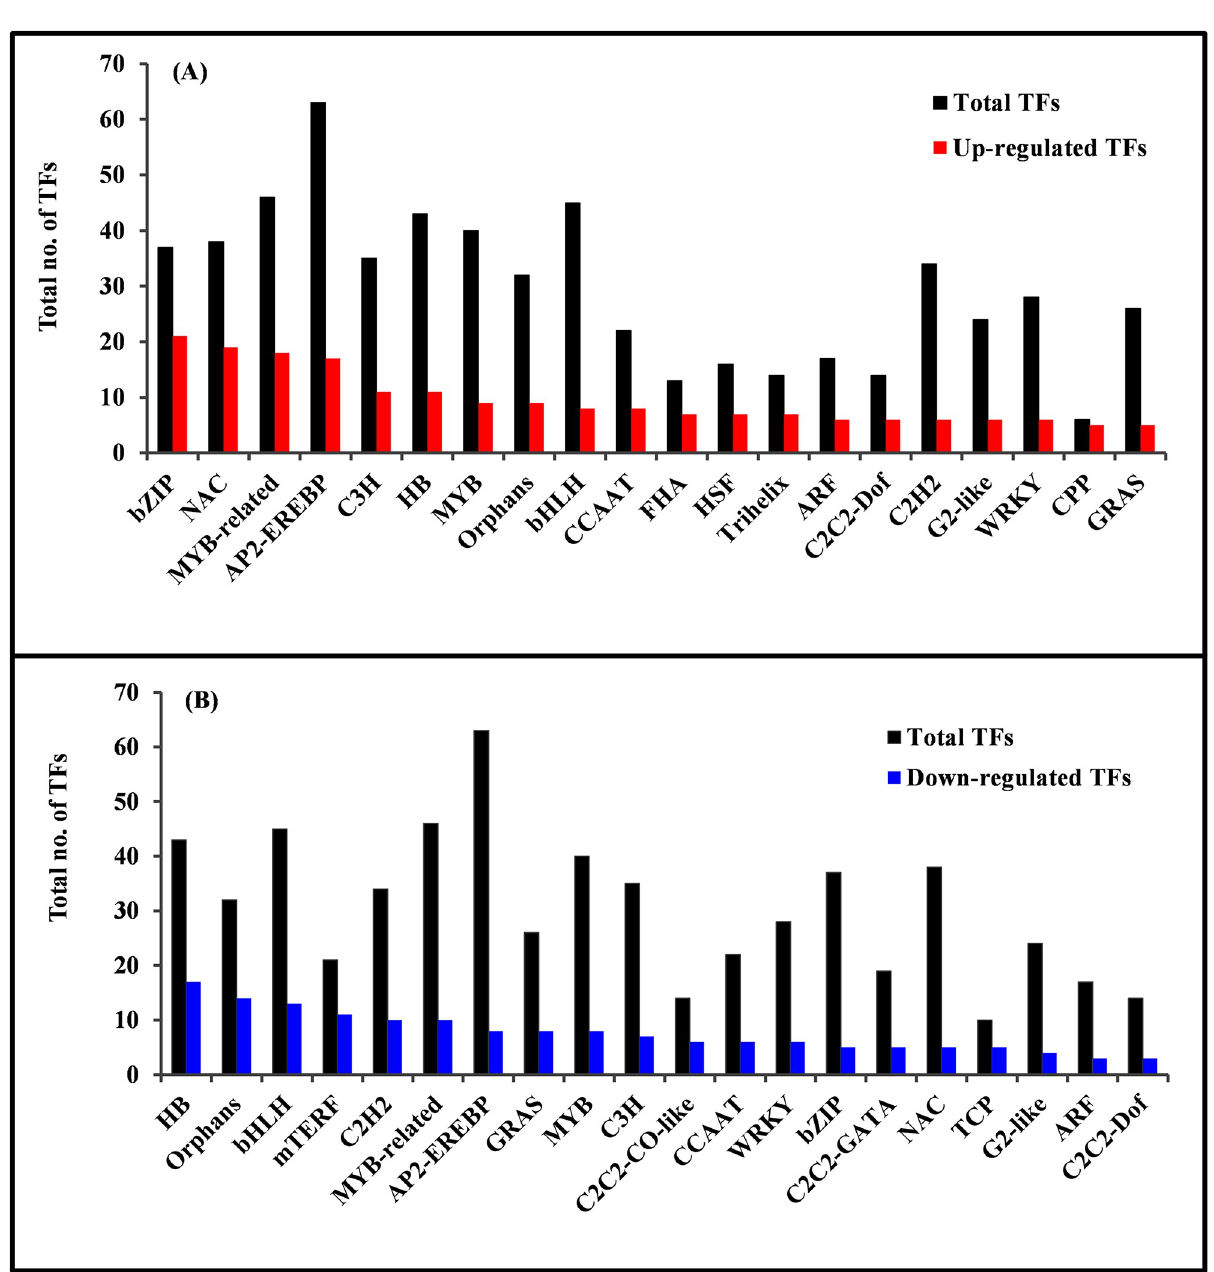
Fig 1. Transcription factor (TF) families identified in our co-expression network are ranked based on number of differentially expressed members (fold-change � |1.2| and p-value � 0.05). In (A) top 20 up-regulated TF families (‘red’ bars), and (B) top 20 down-regulated TF families (‘blue’ bars) are shown. The vertical bars in ‘black’ depict the total number of members of the respective TF families in (A) and (B). The gene-ID-TF mapping is taken from PlnTFDB v3.0.